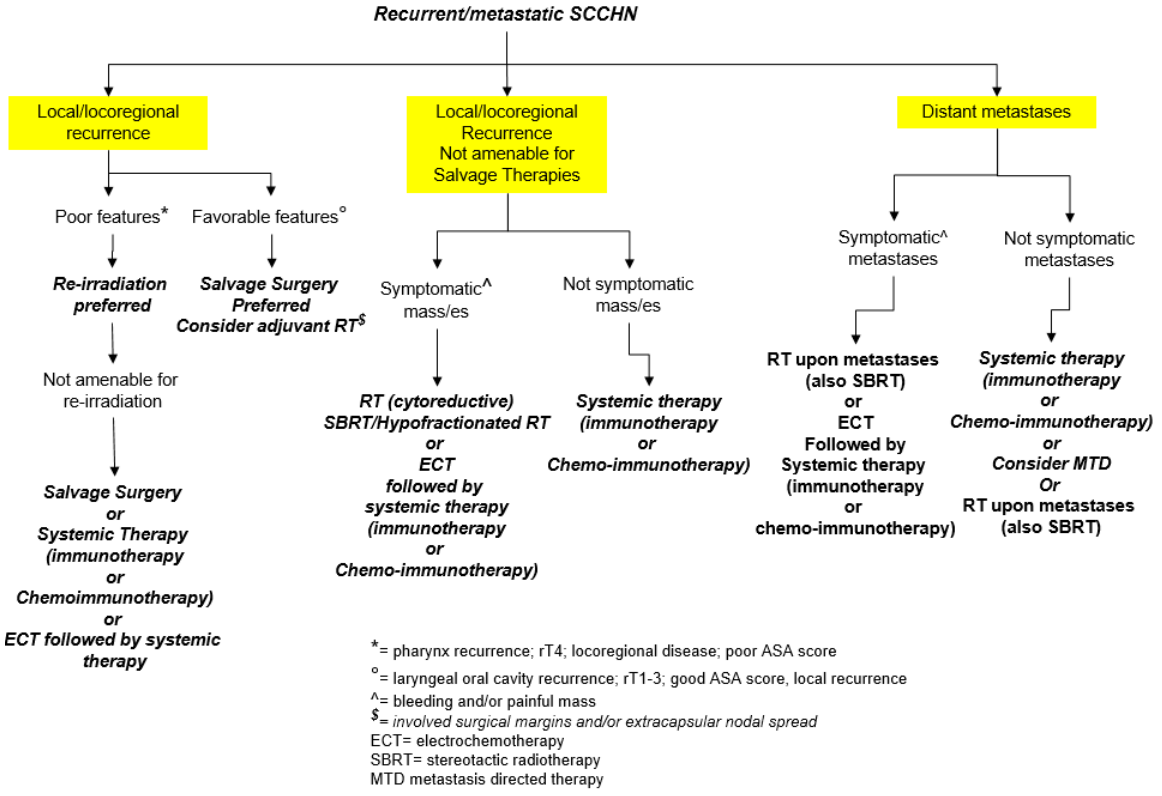
Figure 1. A flow-chart illustrating the therapeutic options in recurrent/metastatic SCCHN. Funding: This research received no external funding. Conflicts of Interest: The authors declare no conflict of